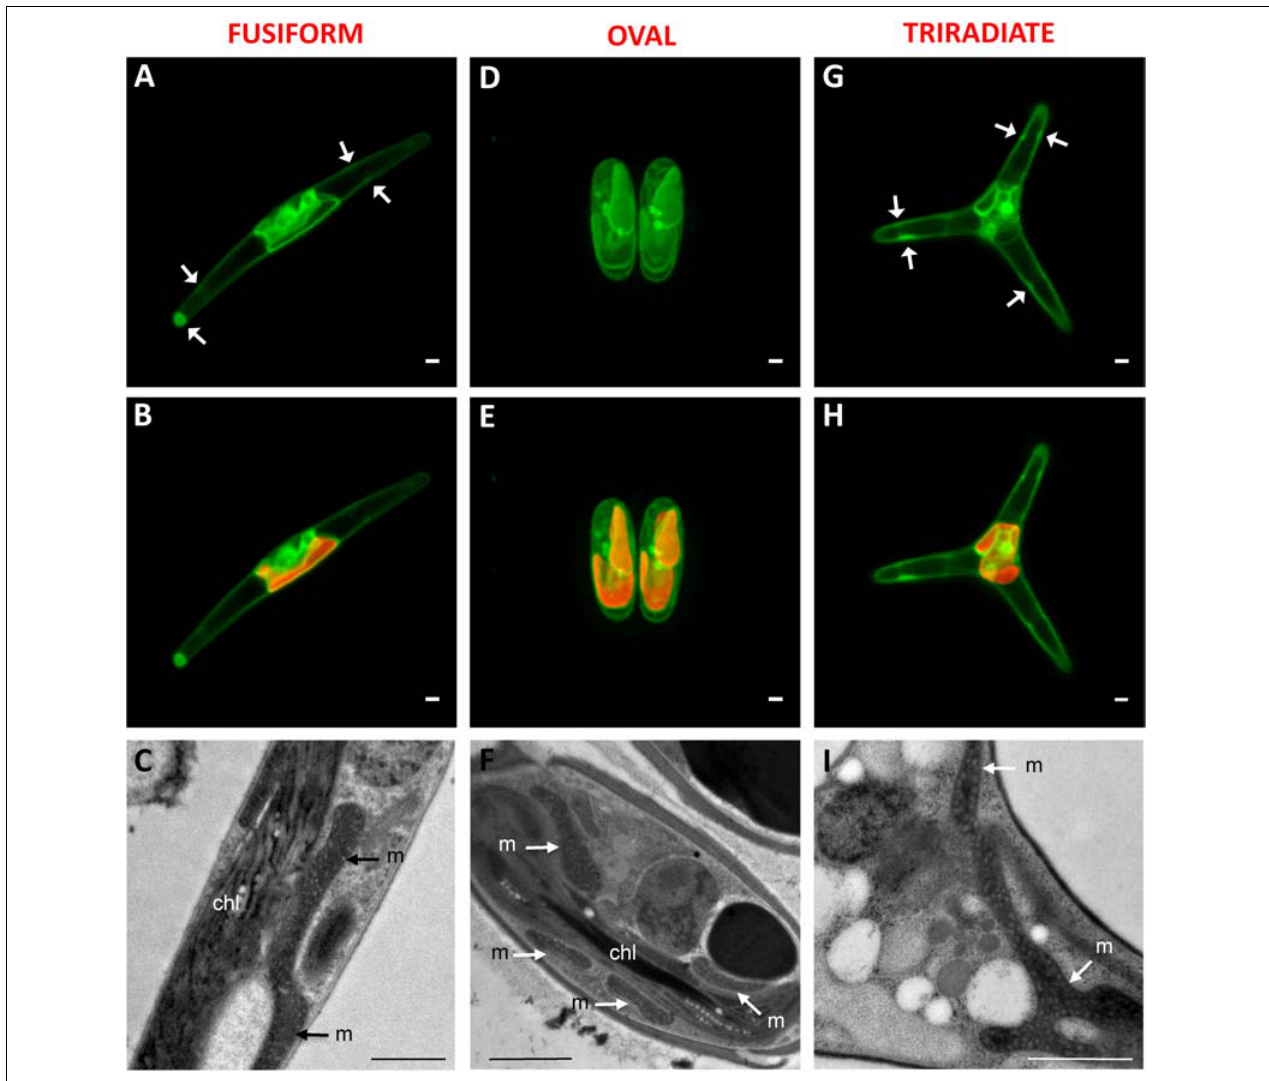
FIGURE 4 | Localization of mitochondria in living P. tricornutum Pt3 morphotypes. (A,D,G) Localization of mitochondria in Pt3 morphotypes in living cells after staining with Mitotracker Green in the fusiform morphotype (A) , oval morphotype (D) , and triradiate morphotype (G) . White arrows indicate peripheral spots of Mitotracker Green staining. (B,E,H) Combination of Mitotracker Green images with plastid autofluorescence in the three Pt3 morphotypes. Enlarged views of tubular mitochondria on Transmission Electron micrograph of each morphotype (C,F,I) . chl: plastid; m: mitochondria. Bars, 1 µ